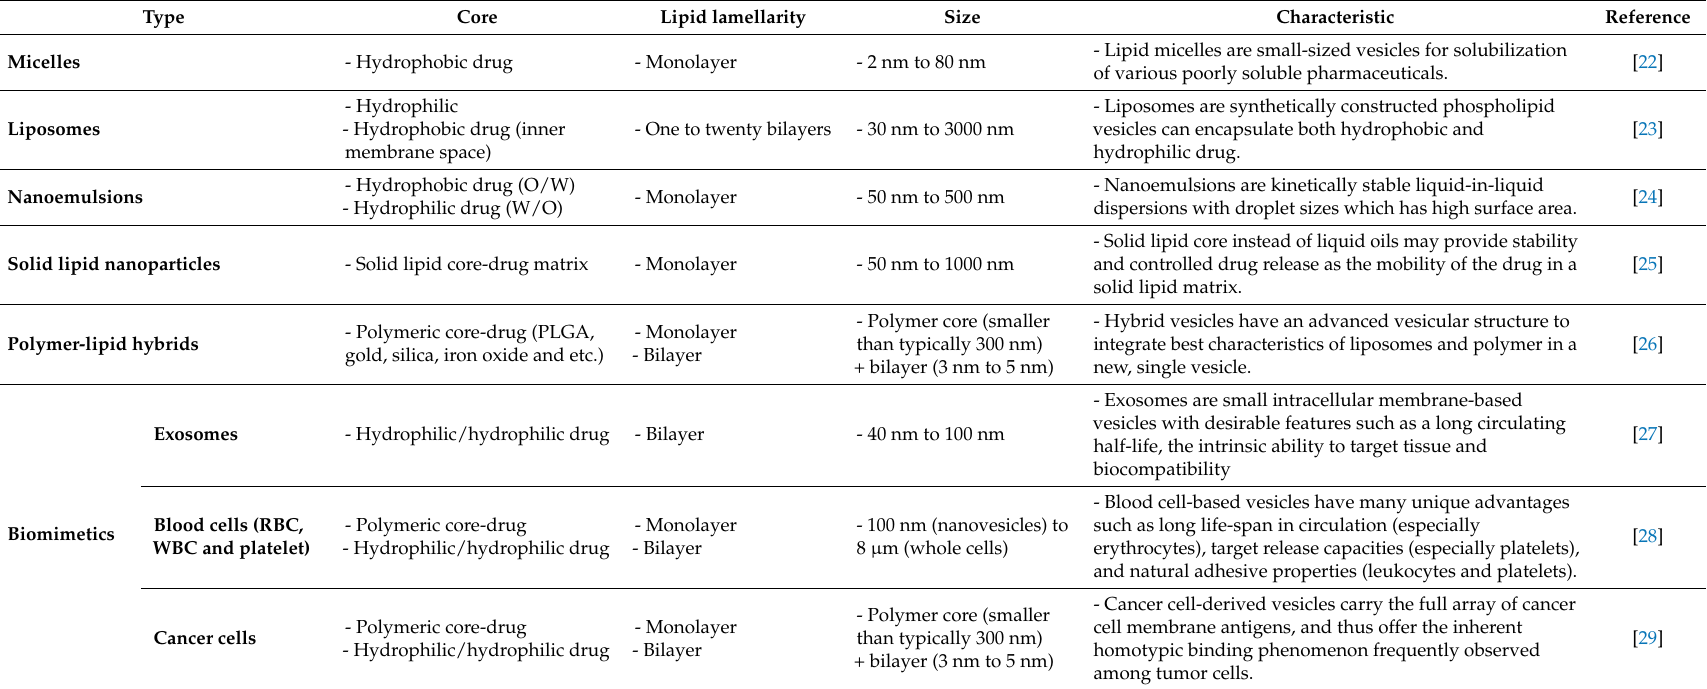
Table 1. Main lipid-based drug delivery systems and summary of their